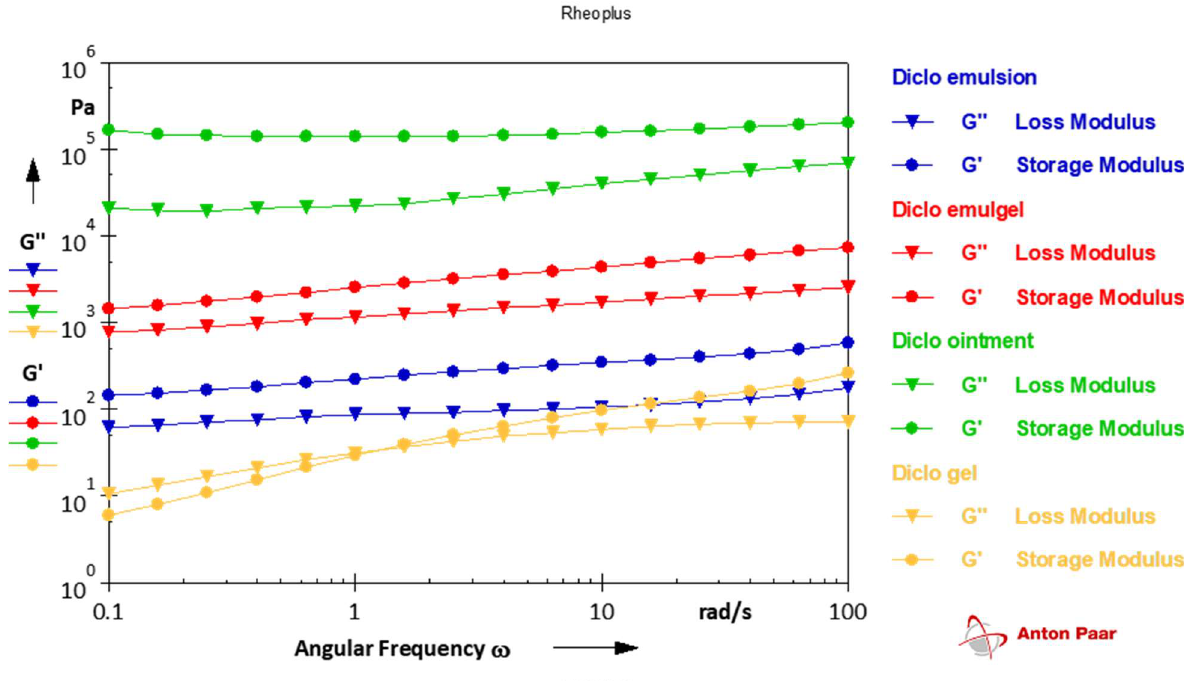
Figure 2. Frequency sweep test for different semi-solid formulations containing diclofenac sodium (1%). Table 3. Low, Medium, and High Shear Viscosity Values for the semi-solid formulations containing diclofenac sodium (1%).